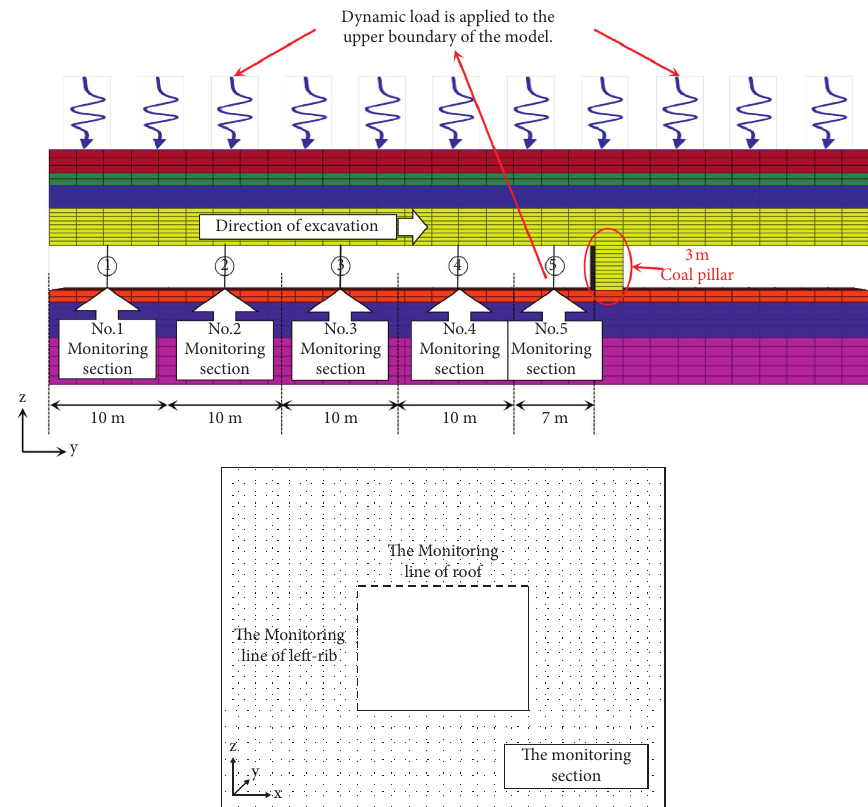
Figure 6: Numerical simulation of roadway excavation and the layout of roadway monitoring line.